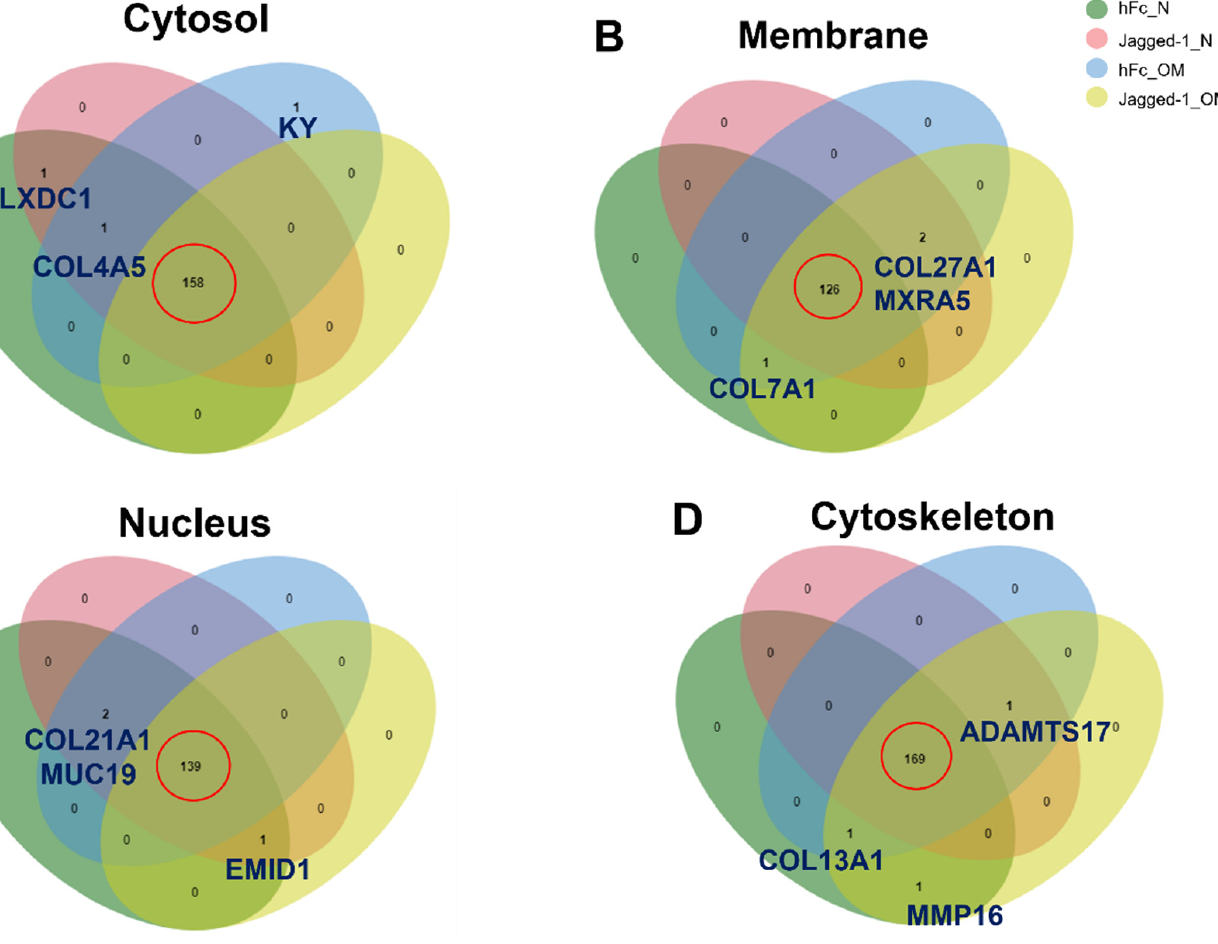
Figure 5. Venn diagram of common proteins and unique proteins presented in the ( A ) cytosol, ( B ) membrane, ( C ) nucleus, and ( D ) cytoskeleton compartment, respectively. The analyses were performed using an interactive Venn diagram viewer [31]. The red circle indicated the common matrisome proteins of the different culture conditions.